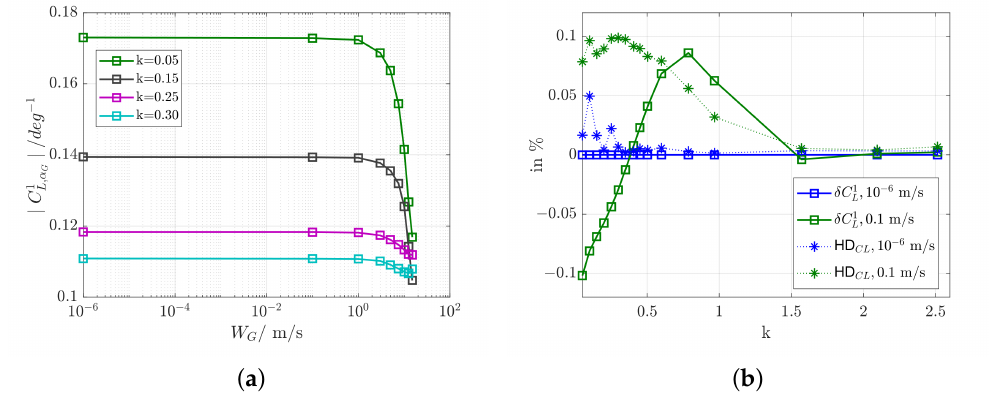
Figure A3. Verification of linearity for low-amplitude results at Mach 0.70. ( a ) First harmonic of the lift, ( b ) Harmonic deviation and and harmonic distortion of the lift for the two lowest excitation